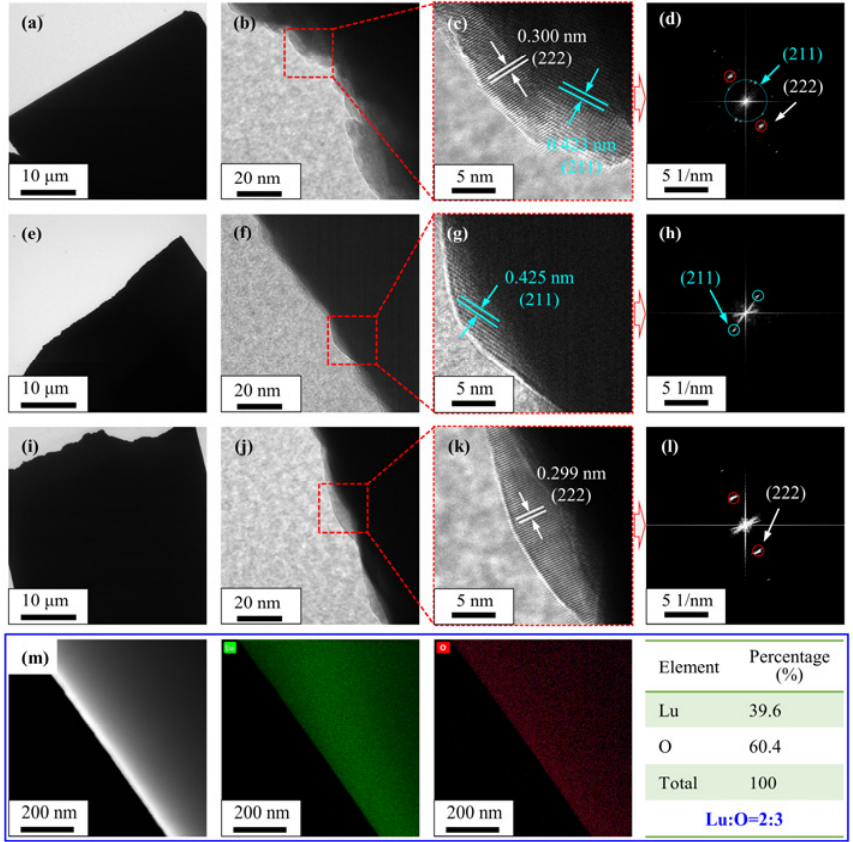
Fig. 9 TEM images and FFT images of (a–d) PAWVT-145–1100, (e–h) PAWVT-145–1200, and (i–l) PAWVT-145–1300. (m) High-angle annular dark field (HAADF) image and element distributions and contents of